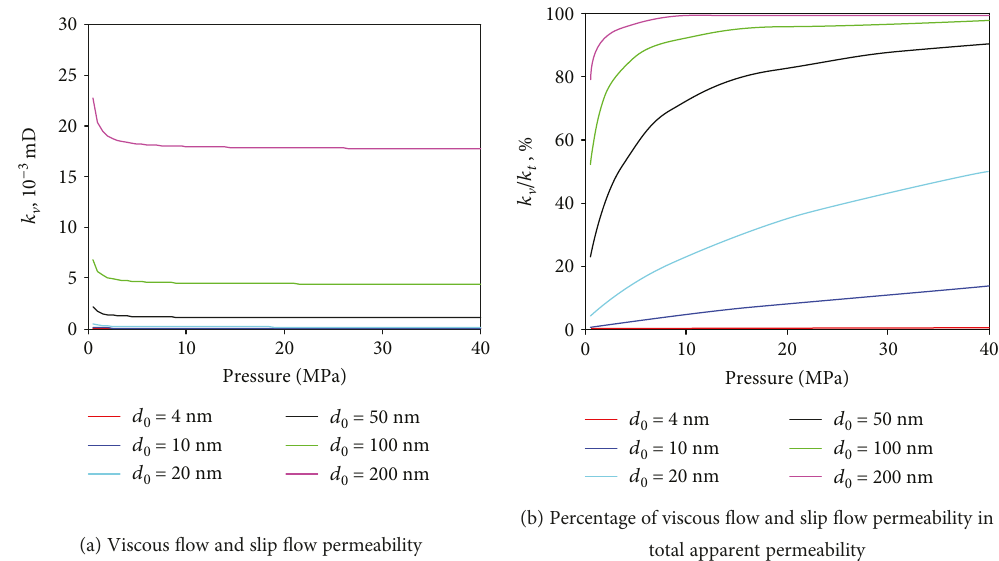
Figure 10: Viscous fl ow and slip fl ow permeability and their percentage in total apparent permeability.